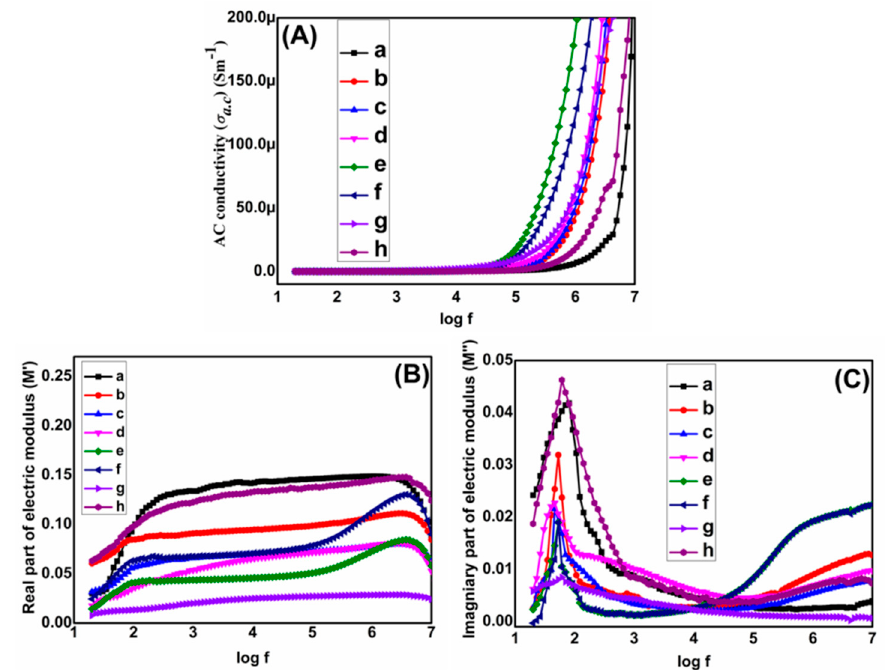
Figure 6. ( A ) AC conductivity ( σ ac ) ( B ) Real part of electric modulus (M ′ ) ( C ) Imaginary part of electric modulus (M ″ ) of ( a ) PVDF ( b ) G1T10PVDF ( c ) G2T10PVDF ( d ) G3T10PVDF ( e ) G4T10PVDF ( f ) G5T10PVDF ( g ) G4T20PVDF ( h ) G4T30PVDF.